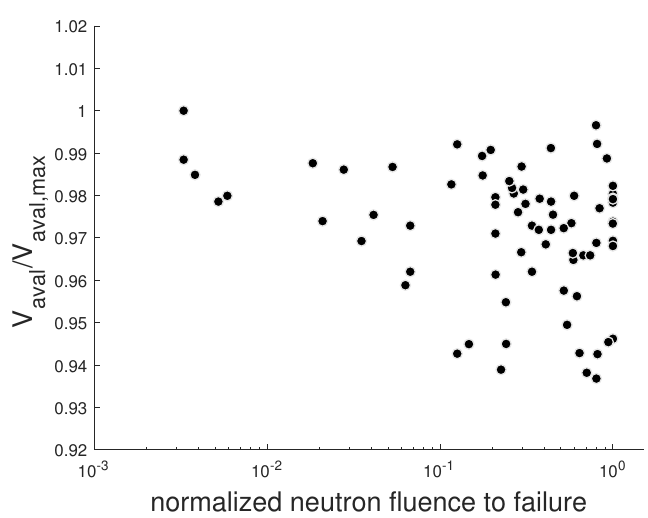
Figure 11. Scatter plot of the normalized V aval versus the normalized neutron fluence to failure of the SiC_A SiC MOSFET.